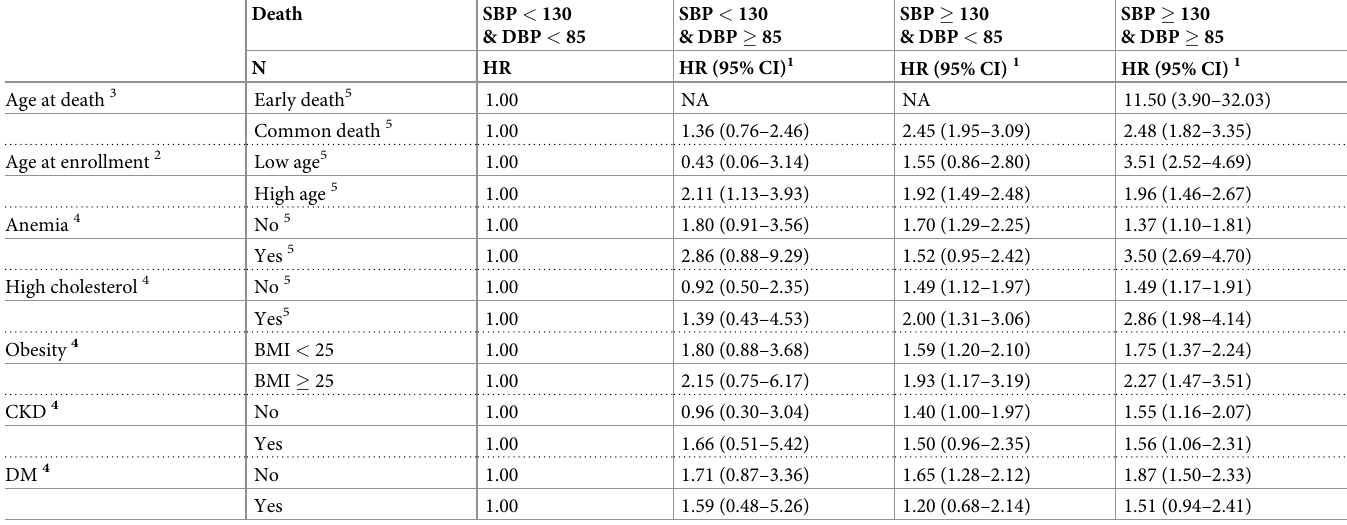
Table 2. Combined association of systolic blood pressure (SBP) and diastolic blood pressure (DBP) on the risk of CVD mortality in stratified analysis by CVD risk factors.